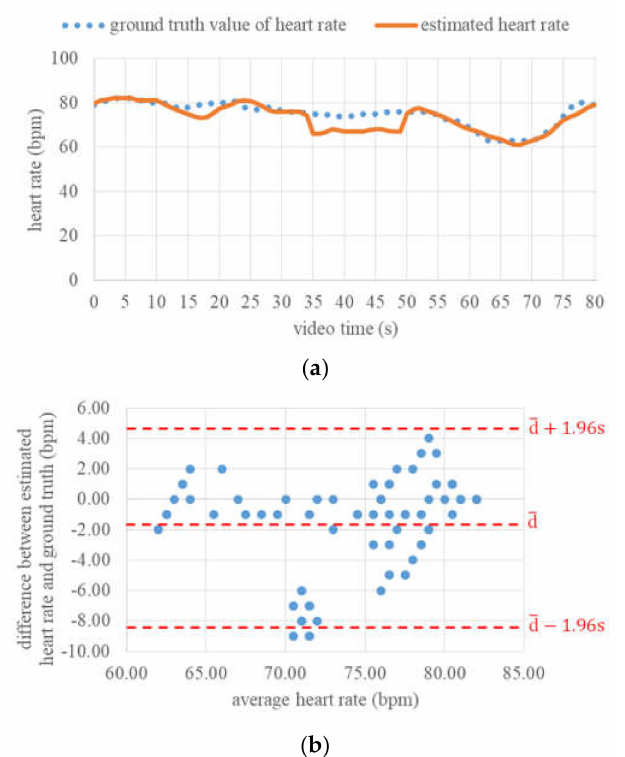
Figure 11. Continuous estimation of heart rate: ( a ) Ground truth values and estimated values of heart rate within 80 s, ( b ) di ff erence between estimated heart rate and ground